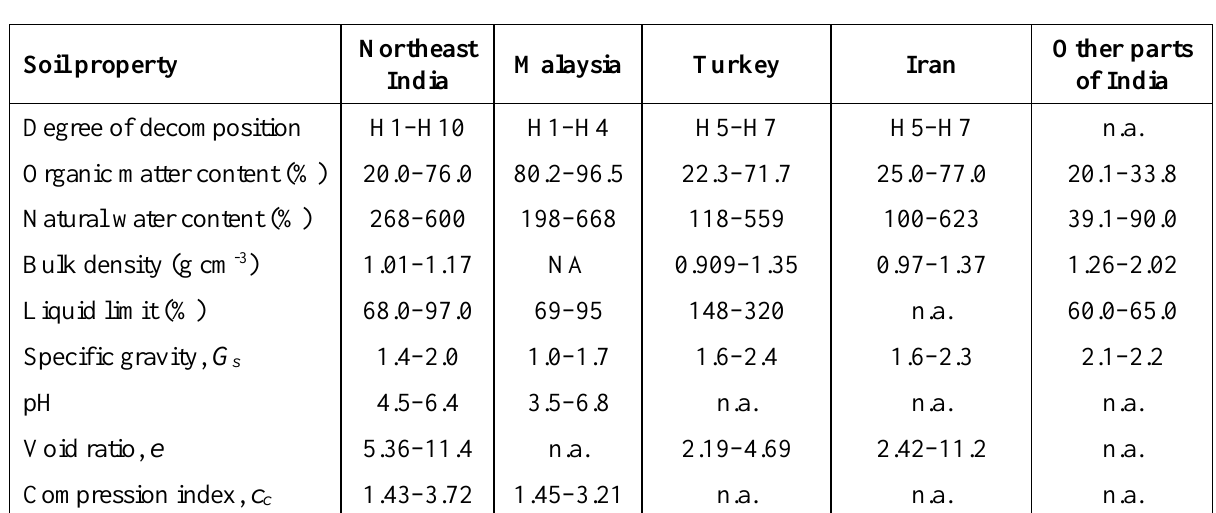
Table 7. Comparison of the properties of Northeast Indian peats with information available from published literature. Data for Turkey are taken from Ulusay et al. (2011); for Iran from Badv & Sayadian (2011); for Malaysia from Duraisamy et al . (2007), Wong et al . (2008), Kalantari & Huat (2009) and Kolay et al . (2011); and for other parts of India from Thomas et al. (1974) and Reddy et al. (2014). n.a. = not